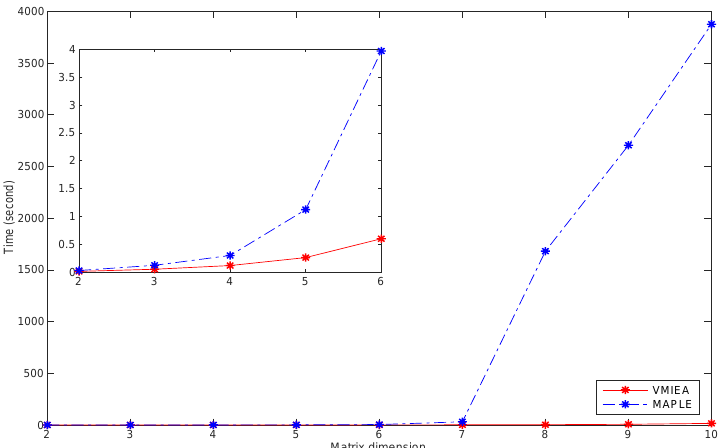
Figure 1. Running time for computing the inverse of symbolic Vandermonde matrix V n ,0 ( x ) via VMIEA algorithm (in red color) and Maple inversion function for matrices (in blue color).